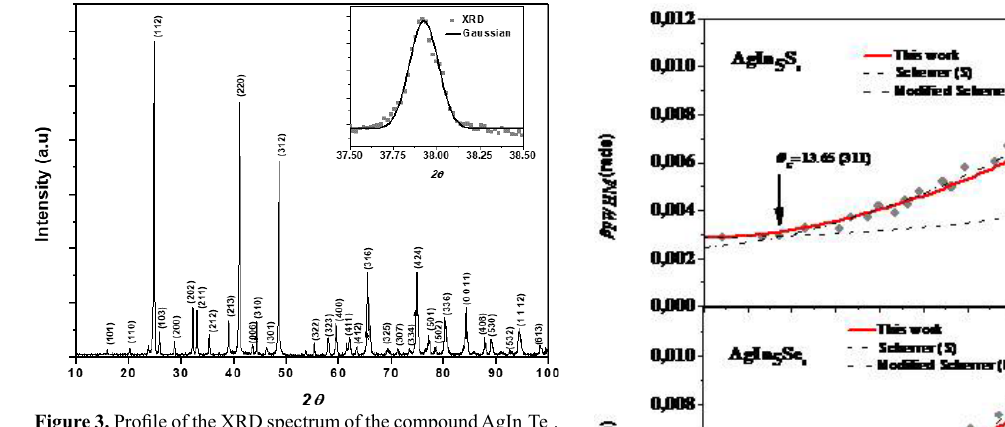
Figure 3. Profile of the XRD spectrum of the compound AgIn The lineshape of the diffraction peaks fit in general to a Gaussian profile, as observed from the inserted figure.